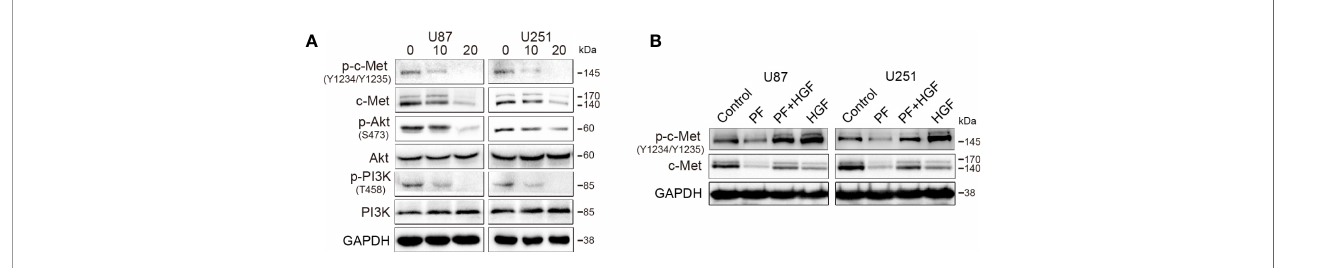
FIGURE 1 | The effects of paeoni fl orin on c-Met in the glioblastoma cell lines U87 and U251. (A) The cells were incubated with the indicated concentrations (0,10,20 m M) of paeoni fl orin for 24 hours, and western blotting was performed to analyze the protein expression levels of c-Met and the downstream signaling molecules. (B) The effect of paeoni fl orin on HGF-induced p-c-Met activity in U87 and U251 cells. U87 and U251 cells were treated with or without 20 m M paeoni fl orin for 24 hours and then incubated with or without 20 nM HGF for 30 minutes. The cells were collected, and western blotting was performed to analyze p-c-Met protein expression levels. All tests were performed in triplicate and the data are presented as the mean ± standard